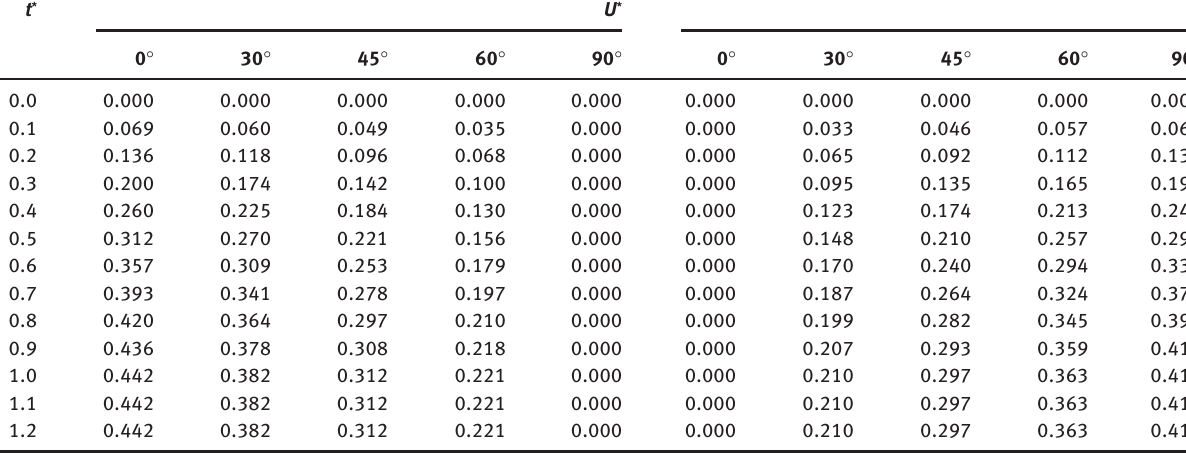
Table 3 Time histories of non-dimensional radial and tangential displacements at points on the inner surface of the shell mid-length and different angular positions.